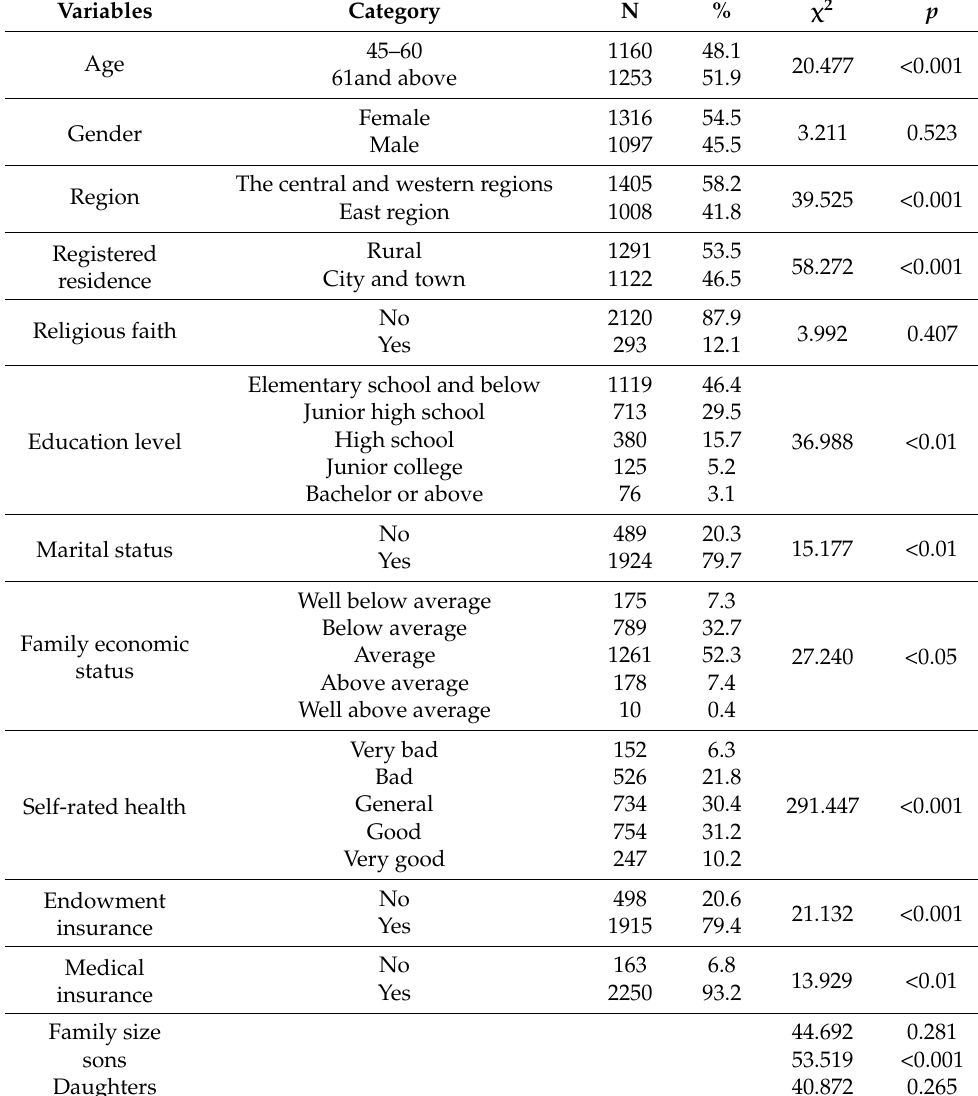
Table 1. Demographic characteristics of the participants (N = 2413).